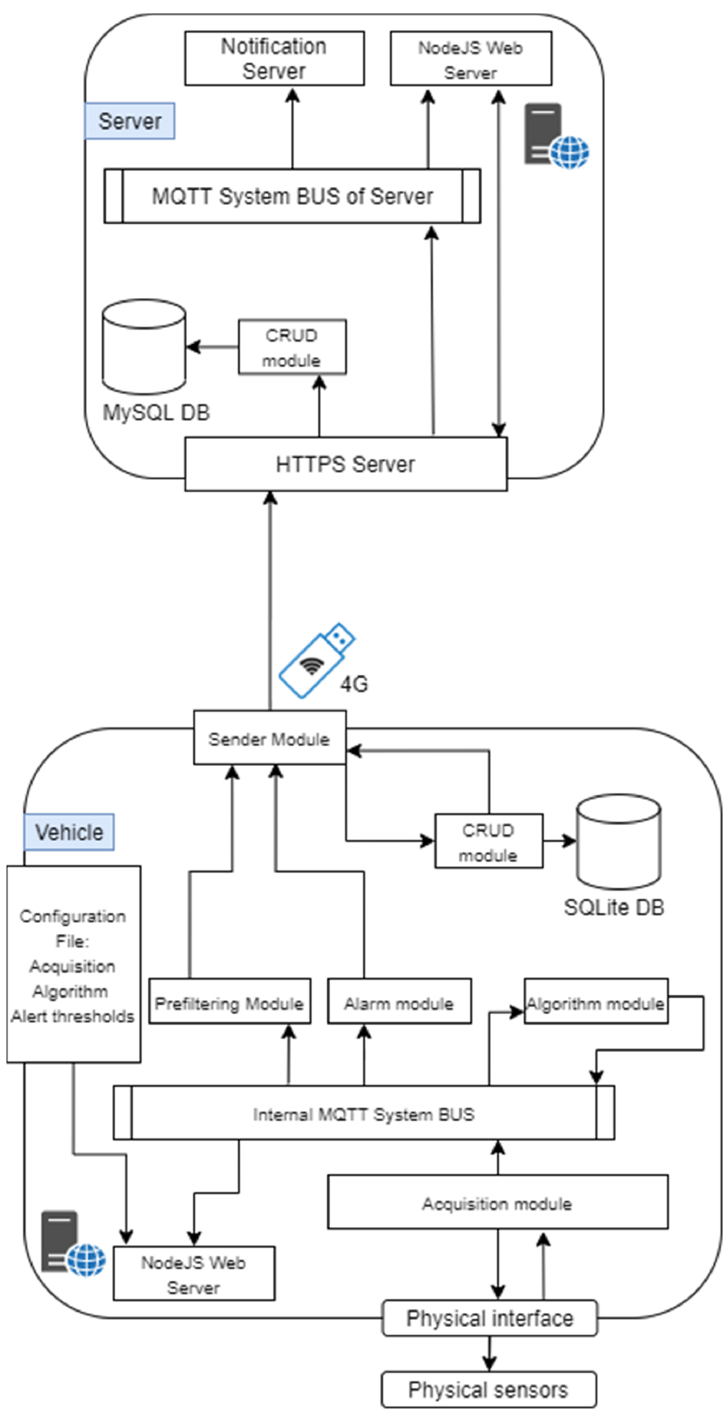
Figure 7. System architecture.